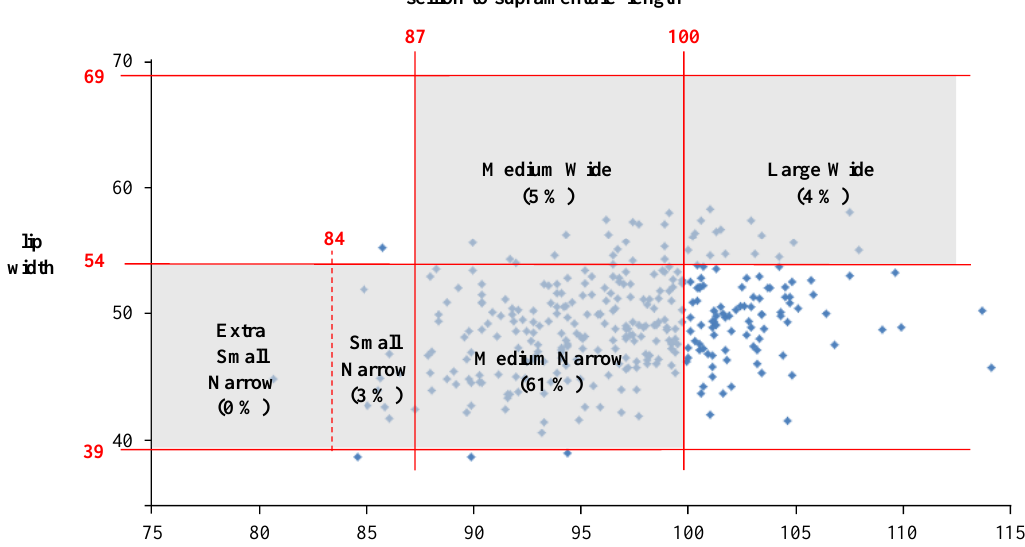
Figure 2. Scatter plot of Republic of Korea Air Force (KAF) pilots in the existing MBU-20/P’s sizing system (accommodation percentage = 73%; dots: 336 KAF pilots).